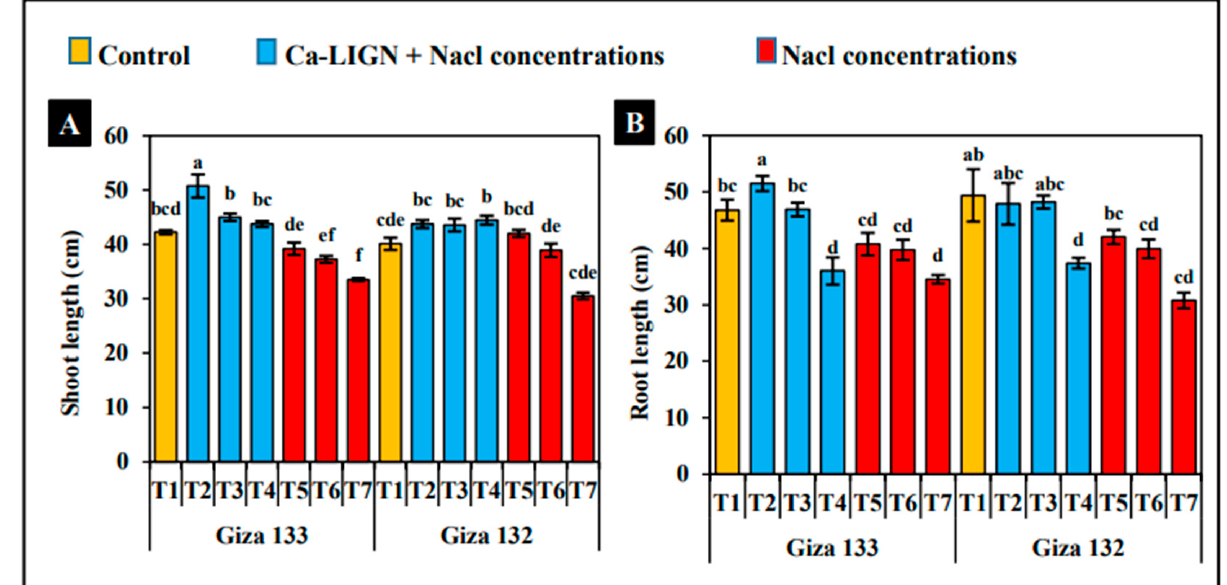
Figure 2. Effect of different treatments: (T1) control, (T2) 100 mM NaCl + Ca-LIGNO, (T3) 200 mM NaCl + Ca-LIGNO, (T4) 300 mM NaCl + Ca-LIGNO, (T5) 100 mM NaCl, (T6) 200 mM NaCl, and (T7) 300 mM NaCl on the average ( A ) shoot length and ( B ) root length of the two barley cultivars, Giza133 and Giza132, during two seasons, 2019/2020 and 2020/2021. Data represent the mean ± SE (n = 4). The same letter indicates no significant difference ( p ≤ 0.05).